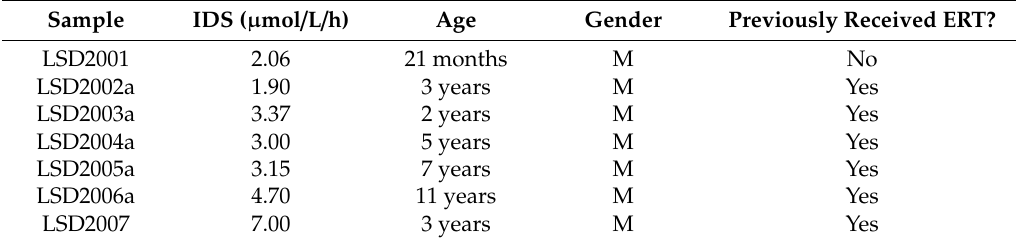
Figure 2. Population distribution of IDS activity ( x -axis, reported as μmol/L/h) in 5301 presumed normal newborn dried blood spot (DBS) specimens (blue bars) and seven known affected newborndriedbloodspot(DBS)specimens(bluebars)andsevenknowna ff ectedMucopolysaccharidosis Mucopolysaccharidosis type-2 MPS II patient DBS specimens (pink bars). type-2 MPS II patient DBS specimens (pink bars). Table 4. Reported IDS Activity in MPS II Patient Table 4. Reported IDS Activity in MPS II Patient Samples.